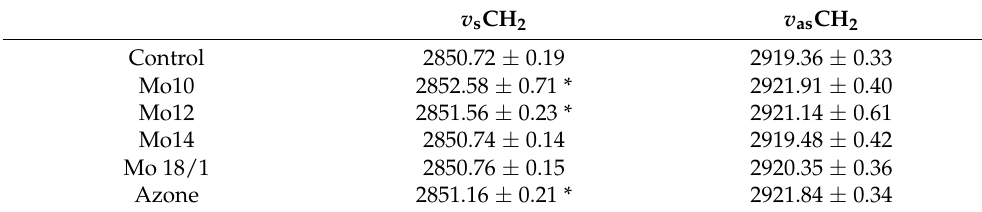
Table 3. Positions of the symmetric and asymmetric CH2- stretching vibrations ( ν s CH2 and ν as CH2, respectively) for the skins treated with selected enhancers measured by ATR-FTIR. Data are presented as means ± SEM, n ≥ 9. * Statistically significant difference compared to the respective control (pure vehicle) at p <